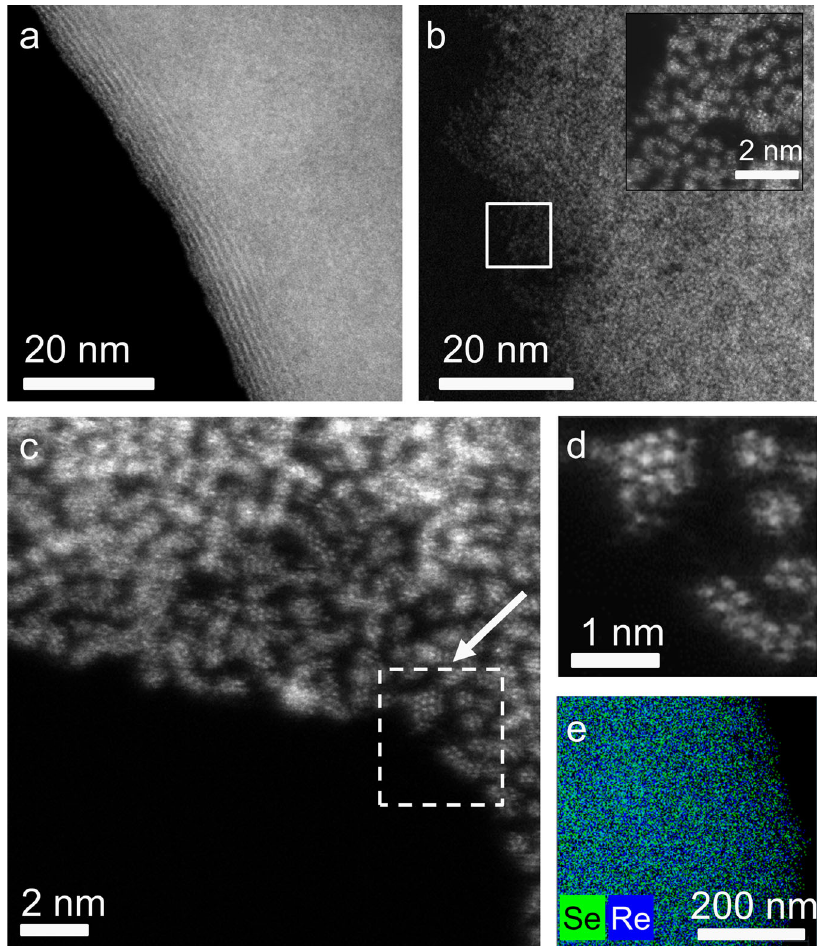
Fig. 2 HAADF-STEM images of the platelets showing the layers of an edge, which is folded parallel to the beam ( a ) and the clusters that make up the layers ( b – d ) and inset in b . An EDX mapping of the platelets showing the homogeneous distribution of both rhenium and selenium in the platelets, is shown in